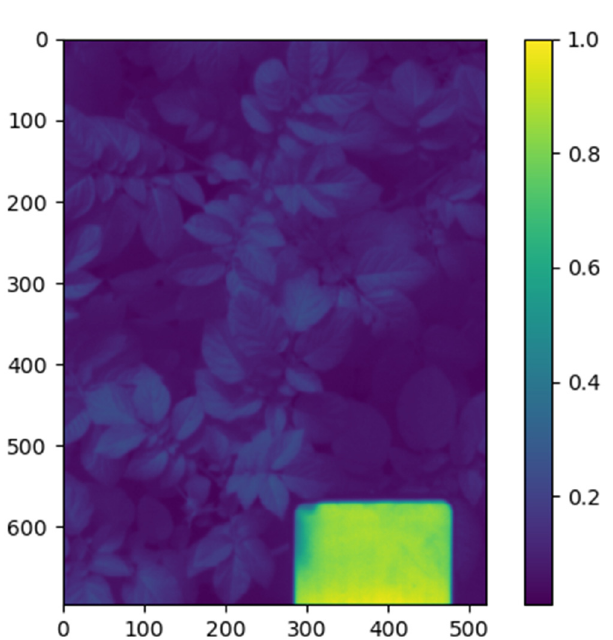
Figure 2. Normalized sum of red, green, blue, NIR bands.